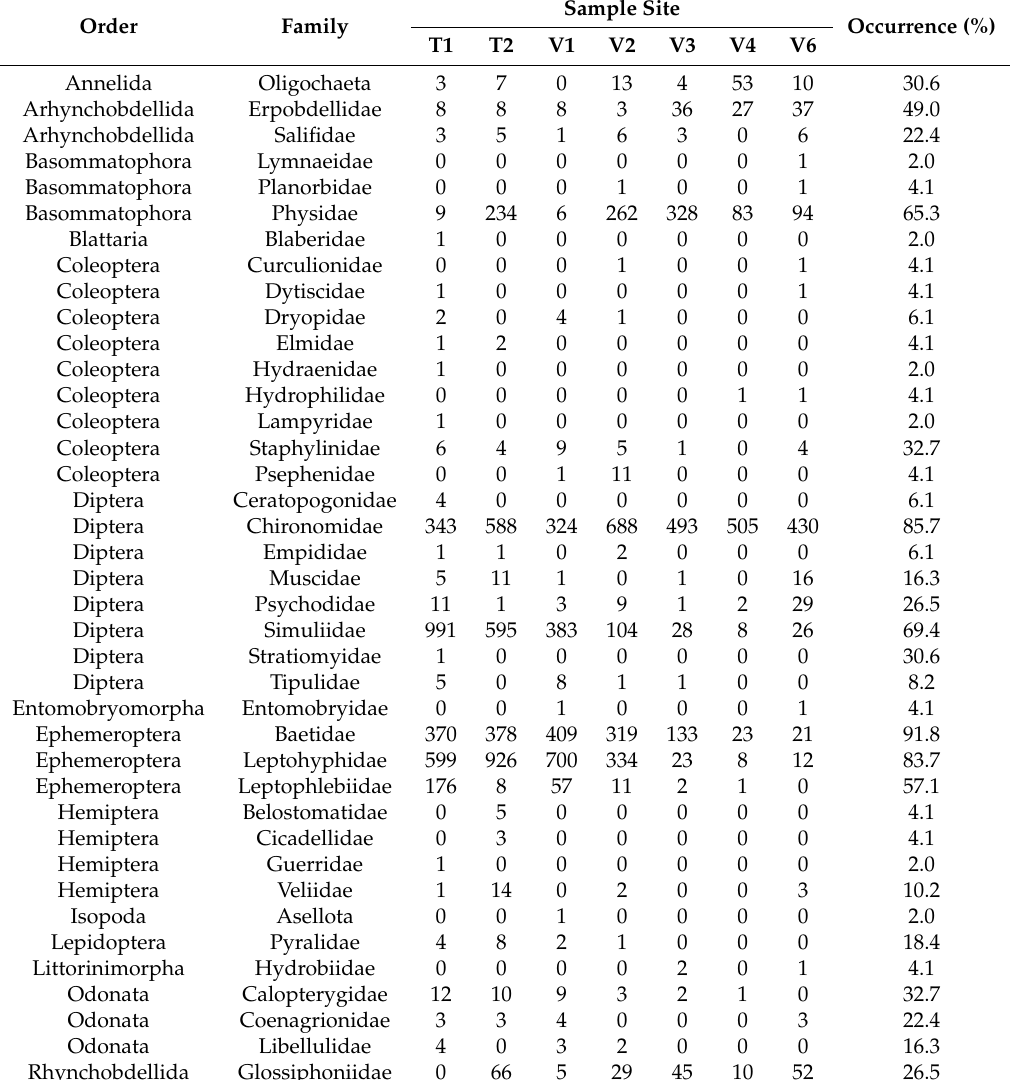
Table A1. Cumulative of families per sample site and occurrence of the macroinvertebrate